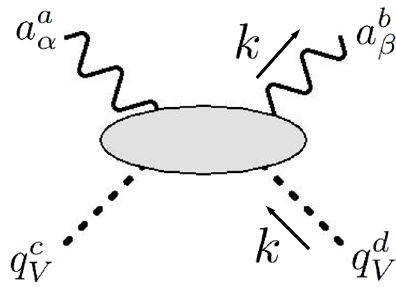
D E A a A b Q c Q d . The other correlation functions can (cid:11) V V (cid:12)